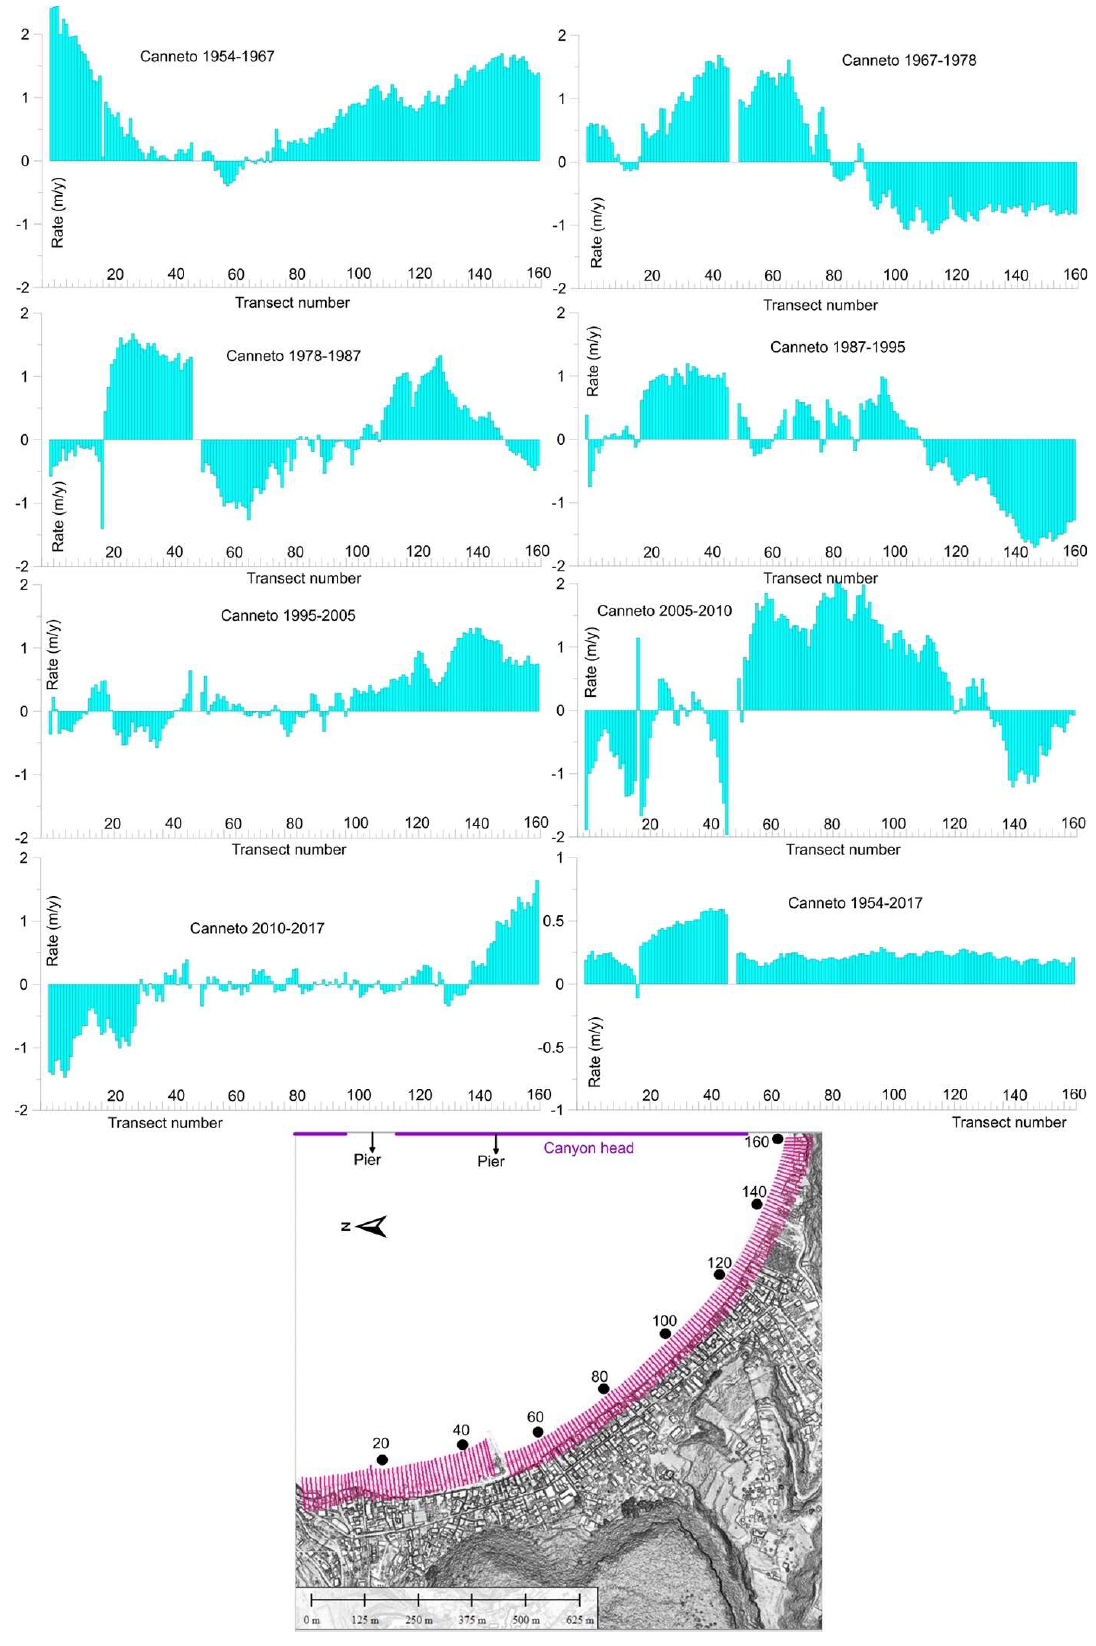
Figure A5. Rate of shoreline displacement for Canneto beach, estimated by means of DSAS along transects spaced 10 m for the different time intervals and for the overall time span of the